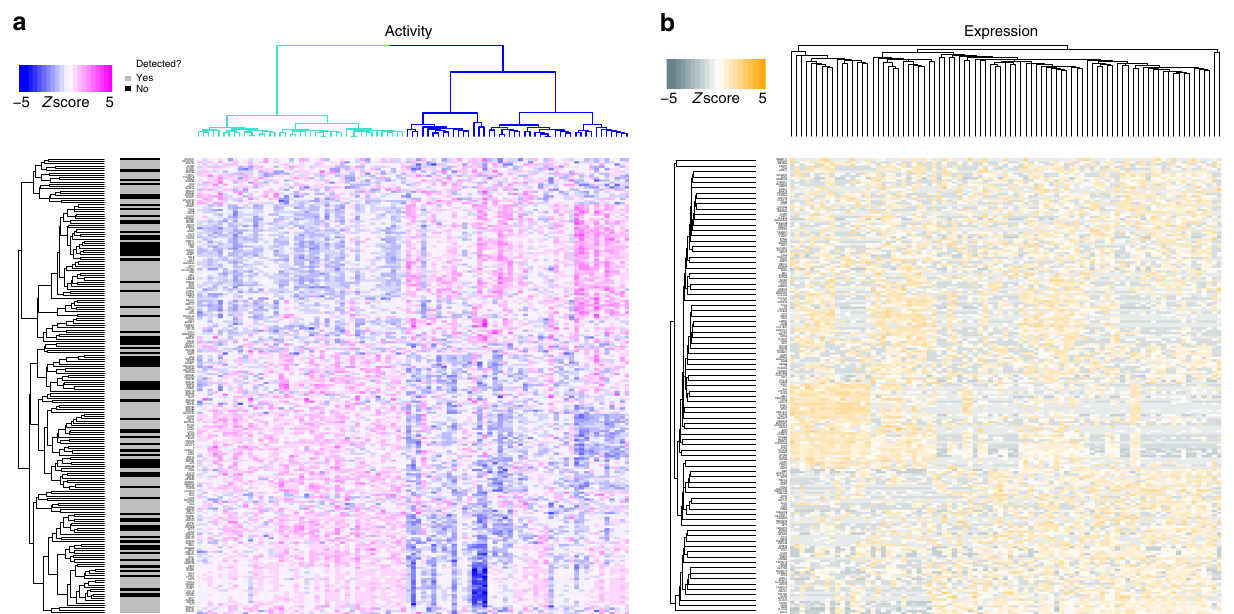
Fig. 2 Inference of protein activity for single cells from GBM mouse model. a MetaVIPER-based protein activity analysis of single cells from a mouse GBM model 27,28 by unsupervised clustering using all annotated transcriptional factors, co-transcriptional factors, and signaling proteins. Two major clusters were identi fi ed, corresponding to established mesenchymal (MES, blue) and proneural (PN, turquoise) subtypes, with varying proliferative (Prolif) potential 11 . Indeed, among the top 200 transcriptional factors (i.e., with the highest inter-cluster activity variability), we found established master regulatory transcriptional factors of the MES ( FOSL1, FOSL2 , RUNX1 , CEBPB , CEBPD , MYCN, ELF4 ), PN ( OLIG2, ZNF217 ), and Prolif ( HMGB2 , SMAD4 , PTTG1 , E2F1 , E2F8 , FOXM1 ) subtypes 13 . b Subtype representation is lost when clustering is performed based on gene expression pro fi